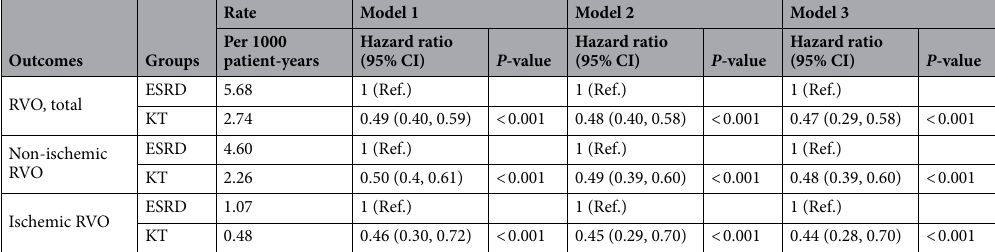
Table 3. Hazard ratio of RVO in ESRD group and KT group. Analysis was performed using Cox regression. Model 1: not adjusted; Model 2: adjusted with age, sex; Model 3: adjusted with age, sex, diabetes mellitus, hypertension, dyslipidemia, Charlson comorbidity index, income status. CI confidence interval, ESRD end stage renal disease, KT kidney transplantation, RVO renal vein